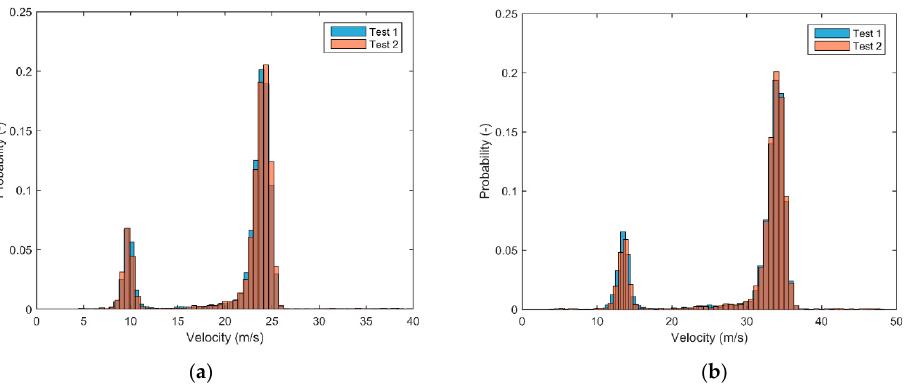
Table 7. Correlation coefficients between two replicates of the static spread pattern as calculated by